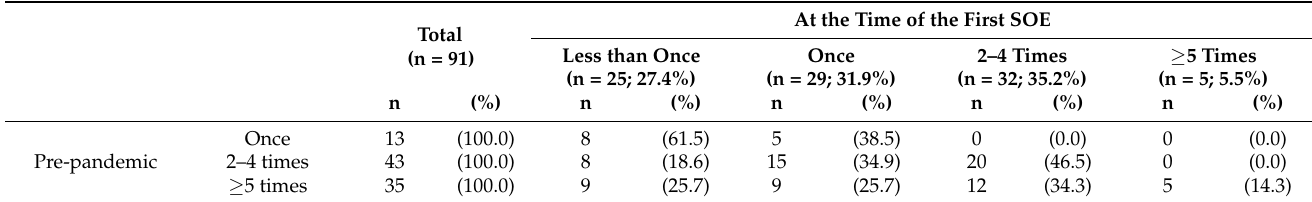
Table 3. Incidence of falls; by frequency of weekly going out (n =